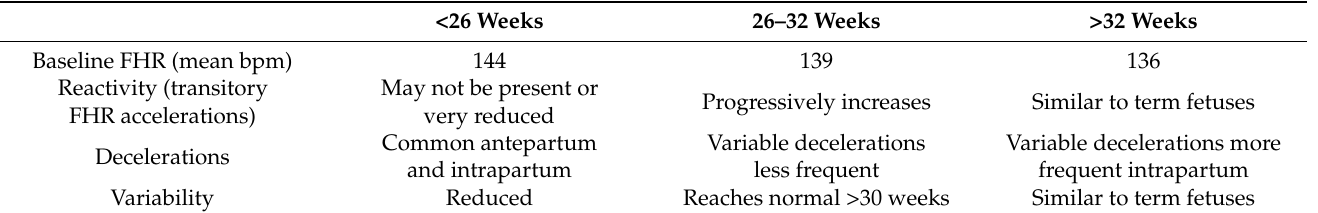
Table 2. Systematic summary of the findings regarding the relationship between FHR signal features and the degree of prematurity. <26 Weeks 26–32 Weeks >32